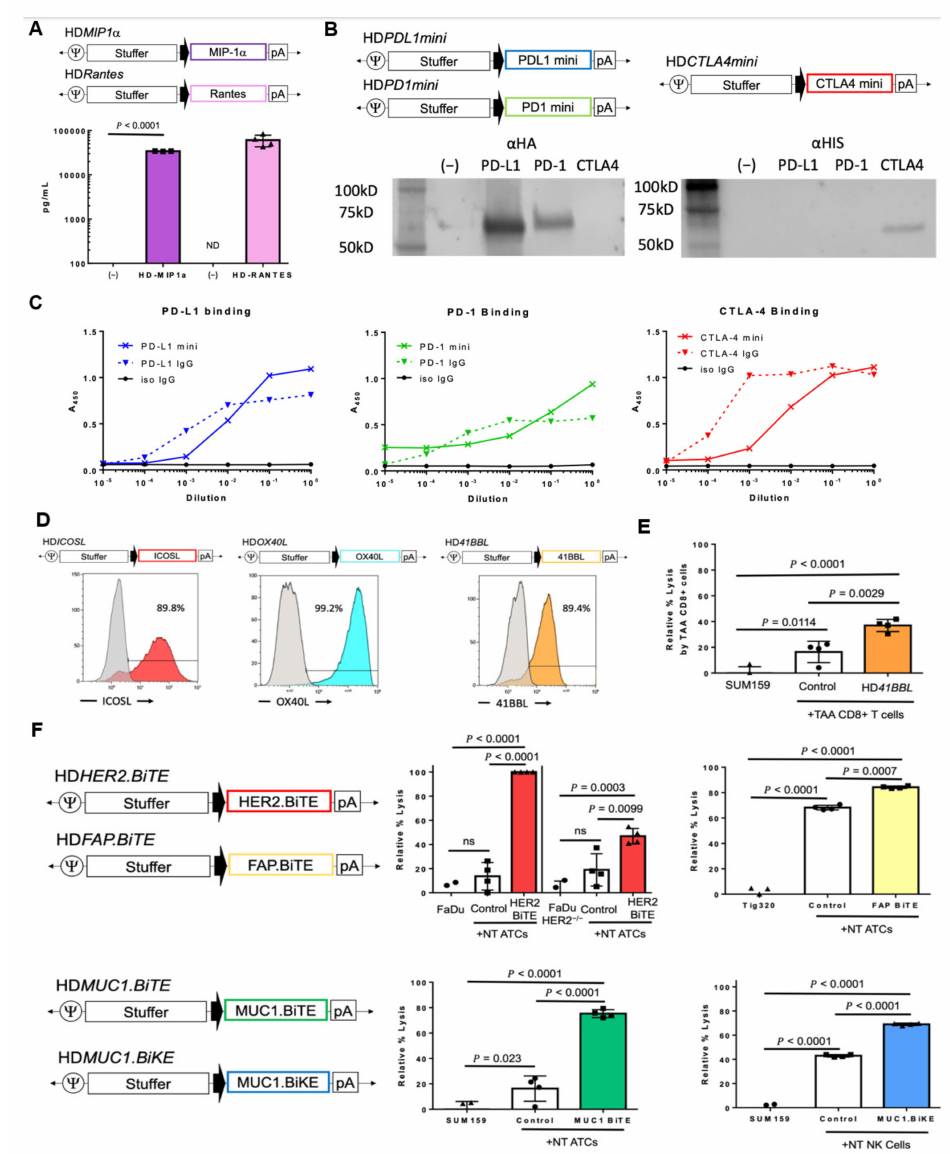
Figure 2. Expression and function of HDAd encoded immunomodulatory molecules. ( A ) Schematic structure of HD MIP1 α and HD Rantes . PC-3 cells were infected with 1000 vp/cell HD5/3 MIP1 α or control HDAd [( − )]( n = 3), A549 cells were infected with 1000 vp/cell HD5/3 Rantes or control HDAd [( − )] ( n = 4). PC-3 media were collected 48 h, A549 at 24 h post-infection, and chemokine levels in the media were measured by ELISA. Data are presented as means ± SD. ND = not detectable. ( B ) Schematic structure of HD5/3 PDL1mini, HD5/3 PD1mini, and HD5/3 CTLA4mini . A549 cells were infected with 100 vp/cell HDAds expressing minibody or control HDAd [( − )], media were collected 48 h post- infection and subjected to western blotting for PDL1 minibody, PD1 minibody, which was detected by anti-HA antibody, and CTLA4 minibody which was detected by anti-HIS antibody. Uncropped blots of Figure 2B are shown in Figure S2 ( C ) Media containing minibody was also assessed for binding to recombinant human protein (PDL1mini:PDL1, PD1mini:PD1, CTLA4mini:CTLA4) by ELISA. Respective IgGs or Isotype IgG were used as controls (10 ug/mL; highest concentration). ( D ) Schematic structure of HD5/3 ICOSL , HD5/3 OX40L , and HD5/3 41BBL . A549 cells were infected with 1000 vp/cell HD5/3 ICOSL , HD5/3 OX40L , or HD5/3 41BBL . Cell surface expression of the respective